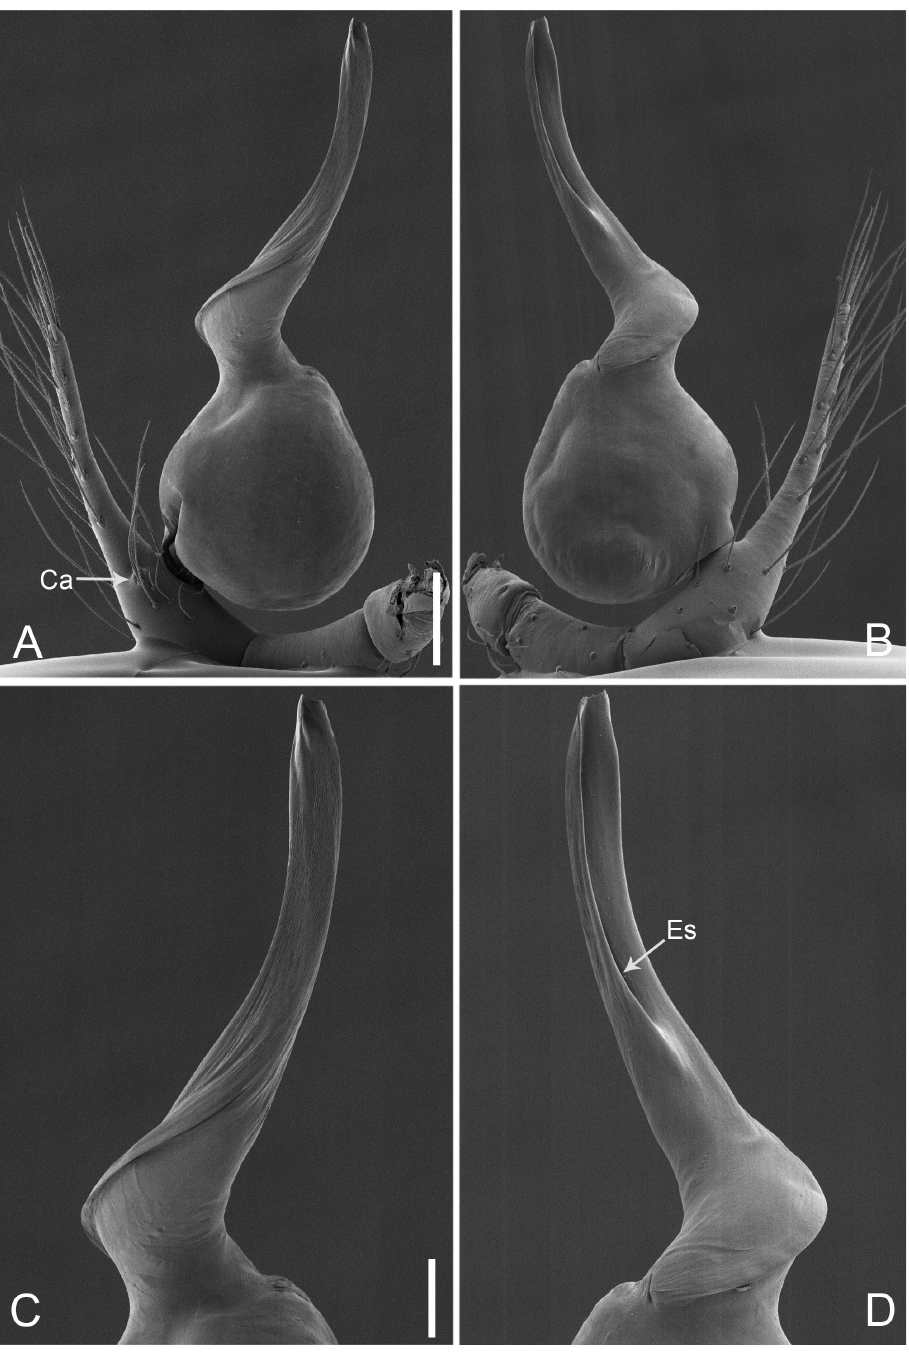
Figure 28. Pinelema zhewang , male. A Palp, prolateral view B Palp, retrolateral view C Embolus, prolat- eral view D Embolus, retrolateral view. Scale bars: 0.1 mm ( A–B ), 0.05 mm ( C–D